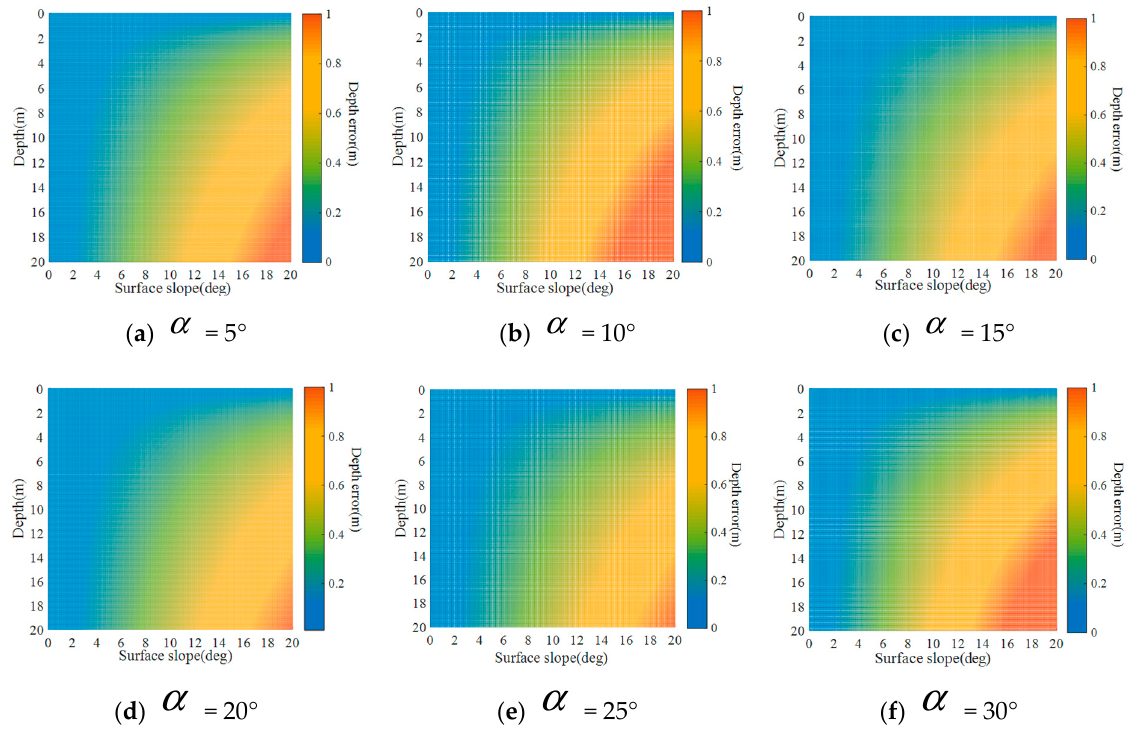
Figure 23. The influence of the laser emission angle and the water surface slope on the depth error. As the water depth of the target water area is less than 20 m, Figure 24 shows the depth deviation when the laser emission angle of the ALB system is 20°. The curves in the figure represent the minimum accuracy requirements of the IHO S-44 Special Order and Order 1a/1b.